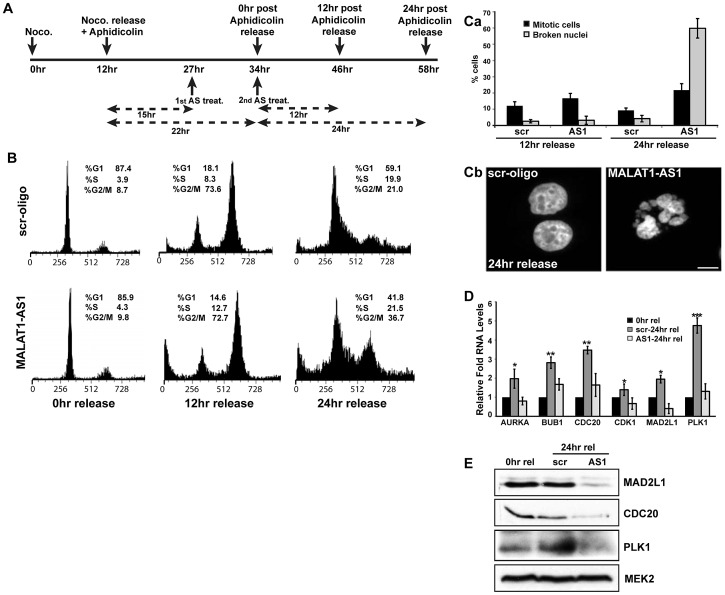
MALAT1 is required for mitotic progression.(A) Flow chart depicting the experimental design. HeLa cells are synchronized in mitosis by nocodazole, released in presence of aphidicolin to synchronize in G1/S. MALAT1 is depleted specifically in G1/S arrested cells and the cells were released for 12 and 24 hr to examine the role of MALAT1 in S-phase and mitotic progression. (B) Flow cytometry analyses of control (scr-oligo) and MALAT1-depleted cells (AS1) post G1/S release. Note the increase in G2/M population in MALAT1-depleted cells (24 hr release). (Ca) Percentage of mitotic cells and cells with broken nuclei in control and MALAT1-depleted cells post G1/S (12 & 24 hr) release. (Cb) Hoechst 33258-stained nuclei in control and MALAT1-depleted HeLa cells post 24 hr G1/S release. (D & E) Effect of MALAT1 knockdown on mitotic gene expression in HDFs. G1/S synchronized WI-38 cells are depleted of MALAT1 followed by release for 24 hr, and relative mRNA and protein levels of indicated genes are determined by qRT-PCR and immunoblot analyses respectively. Note that the MALAT1-depleted cells show reduced expression of mitotic genes compared to scr-oligo-treated cells in post 24 hr release of aphidicolin treatment. MEK2 is used as a loading control. Mean ± SEM, *p<0.05, **p<0.01 and ***p<0.001.